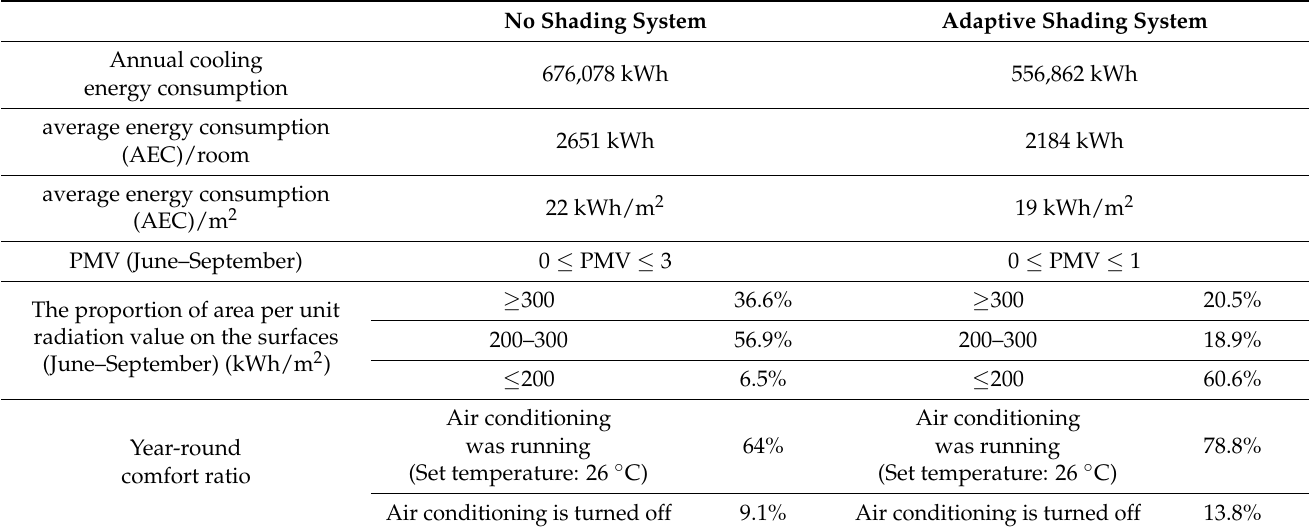
Figure 15. The effects of adaptive shading on comfort, average radiant temperature, and cooling energy consumption. ( a ) The annual comfort simulation with no shading; ( b ) The annual comfort simulation with adaptive shading; ( c ) The annual radiation temperature simulation with no shad- ing; ( d ) The annual radiation temperature simulation with adaptive shading; ( e ) The cooling load simulation with no shading; ( f ) The cooling load simulation with adaptive shading. Table 6. Comparative analysis of the performance objective optimization results.